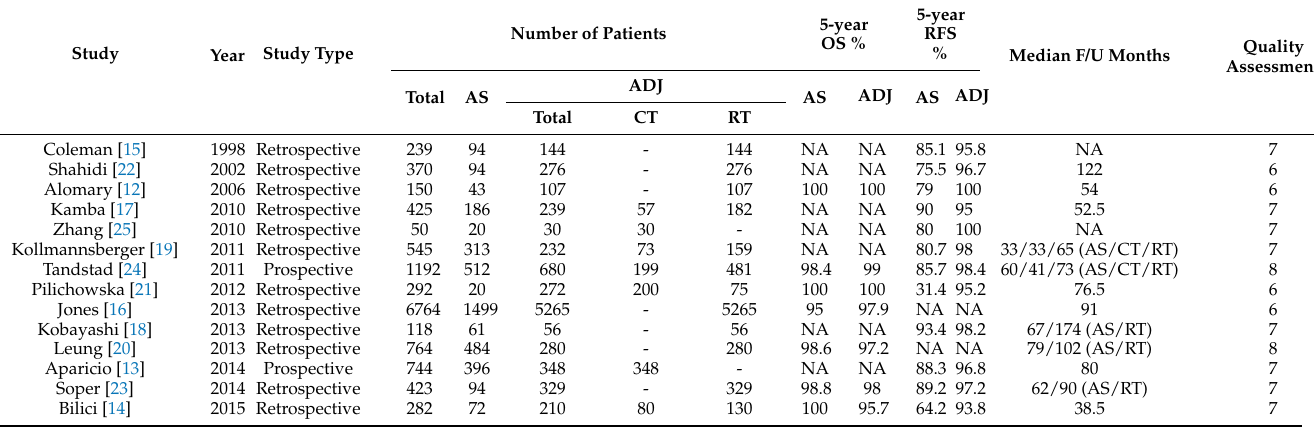
Table 1. Characteristics of the Included Studies.